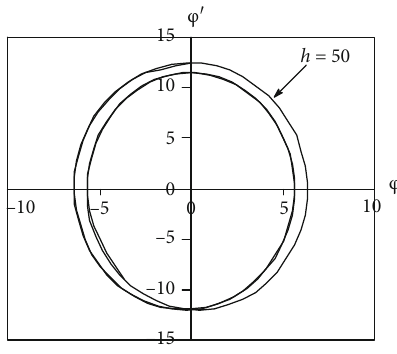
Figure 9: The analytical and numerical stabilities φ ′ against φ at h = 50 .